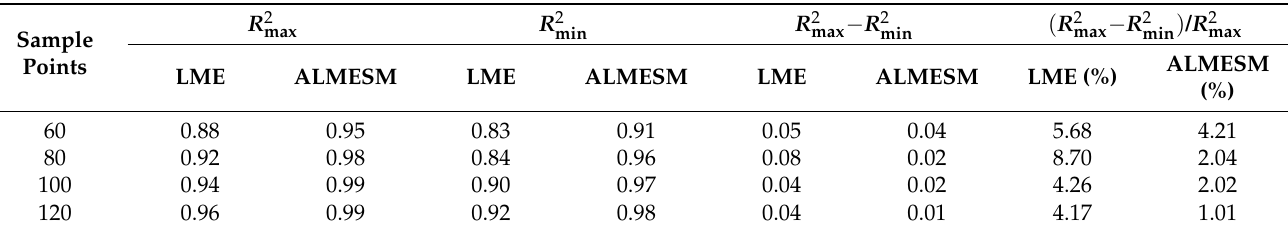
Table 2. Statistical analysis of sampling randomness of the LME and ALMESM.